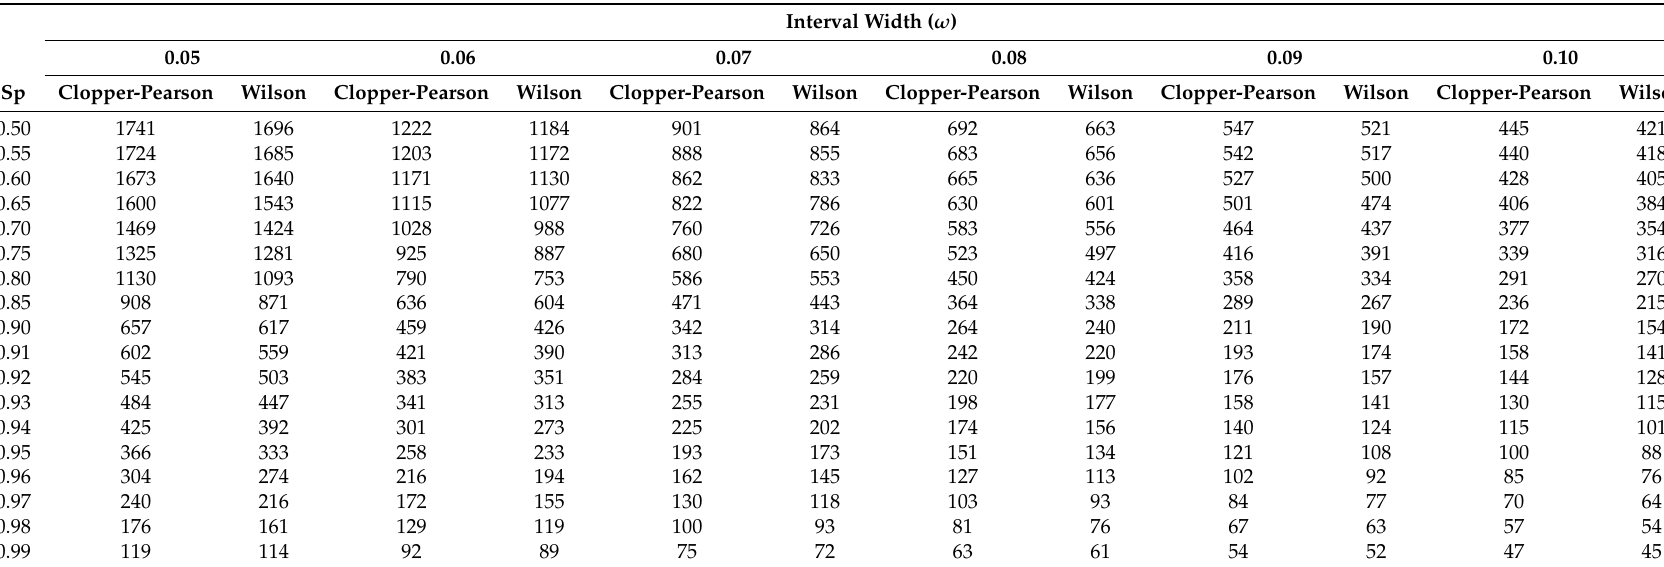
Table 4. Optimal sample sizes ( n optimal ) corresponding to several specificities, for the Clopper–Pearson and Wilson methods, with ω varying between 0.05 and 0.10, admitting η = 0.10, ξ = 10 − 4 , and 95% nominal confidence